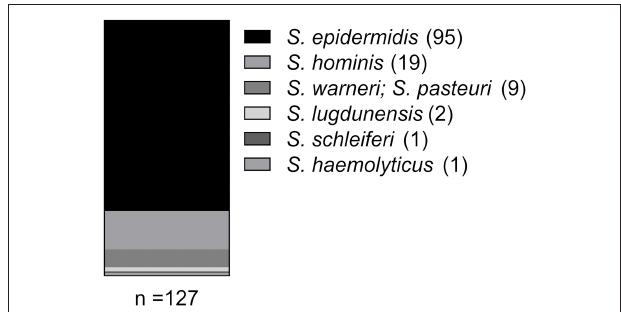
FIGURE 1 | Species distribution among the CoNS isolates as identified by 16S rDNA locus sequence analysis.